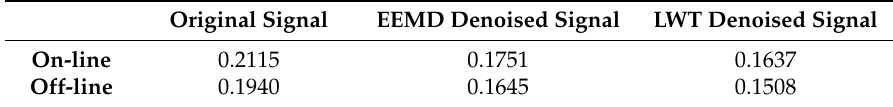
Table 2. Average values of CV calculated by the original and denoised signals.